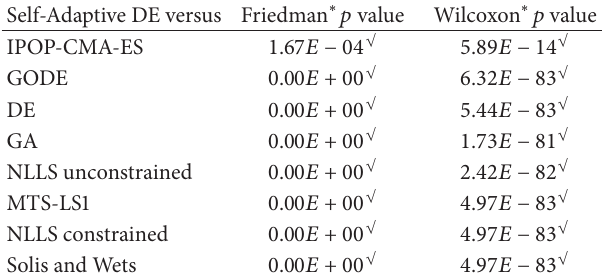
Table 10: Corrected 𝑝 values according to Holm’s method (Self- Adaptive DE is the control algorithm) for the 8-term Fourier